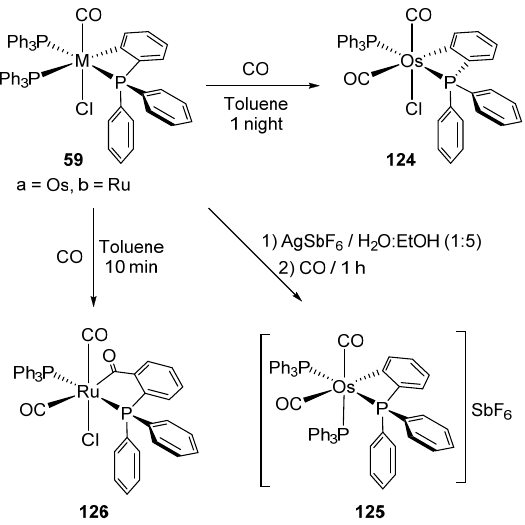
Figure 27. Reactions of four-membered metalacycles.